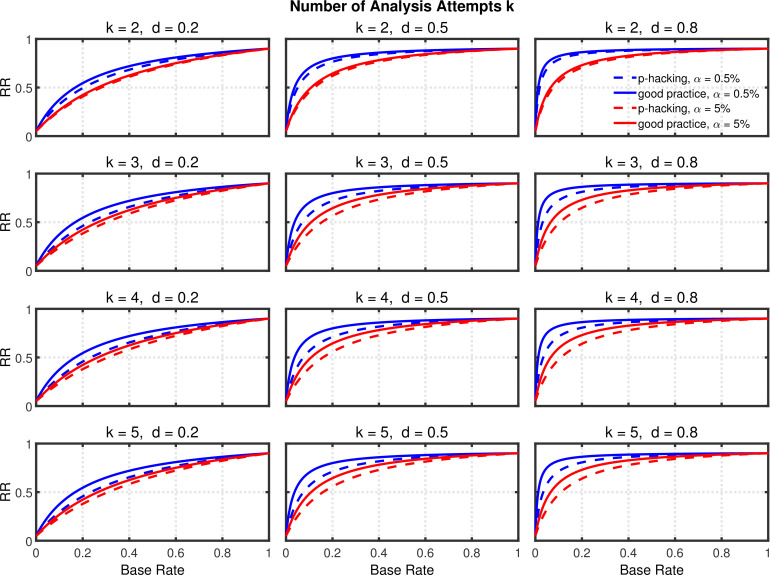
Selective outlier removal.Replication rate (RR) as a function of the number k of outlier rejection methods attempted, effect size d, and nominal α level (0.5% or 5%). The nominal α level and power of the replication study are α2=0.05 and 1-β2=0.90. Dashed lines give the results for p-hacking whereas solid lines depict the results for researchers who act according to good scientific practice. Simulated data included no outliers.